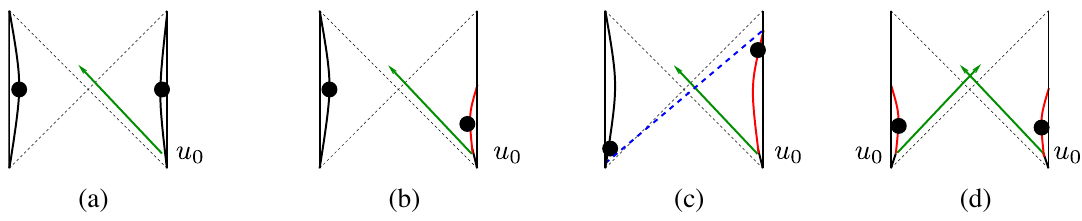
Figure 7 . (a) We insert matter at some early Lorentzian time u 0 < 0 smaller than the scrambling time so that the backreaction on the boundary trajectory is small. (b) Same insertion but beyond the scrambling time. There is a large change in the boundary trajectory. (c) The same as (b) but after an overall boost (a gauge transformation) that explains better why there is a maximum momentum. Here we have kept the point u 0 (cid:12)xed in the (cid:12)gure so that increasing it corresponds to moving the left and right dots (the times where we evaluate the charges) down and up. The point is that the boost angle between the green line (the matter we inserted) and the blue dotted line is (cid:12)nite. The blue dotted line represents that highest boost angle for a geodesic joining the two black dots at late times. (d) We insert matter on both sides. In this case, one can show that the energy continues to increase as we take u 0 beyond the scrambling